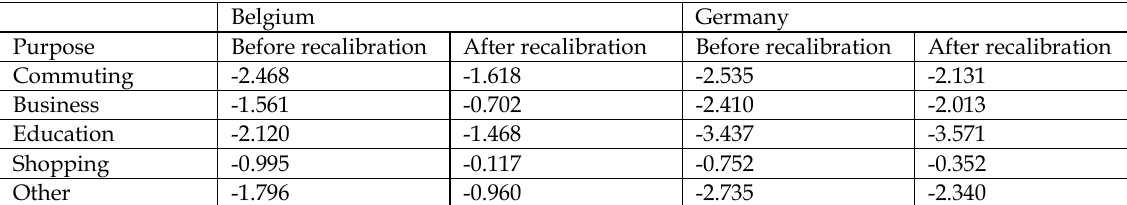
Table 5. Border resistance coefficients before and after recalibration to count data